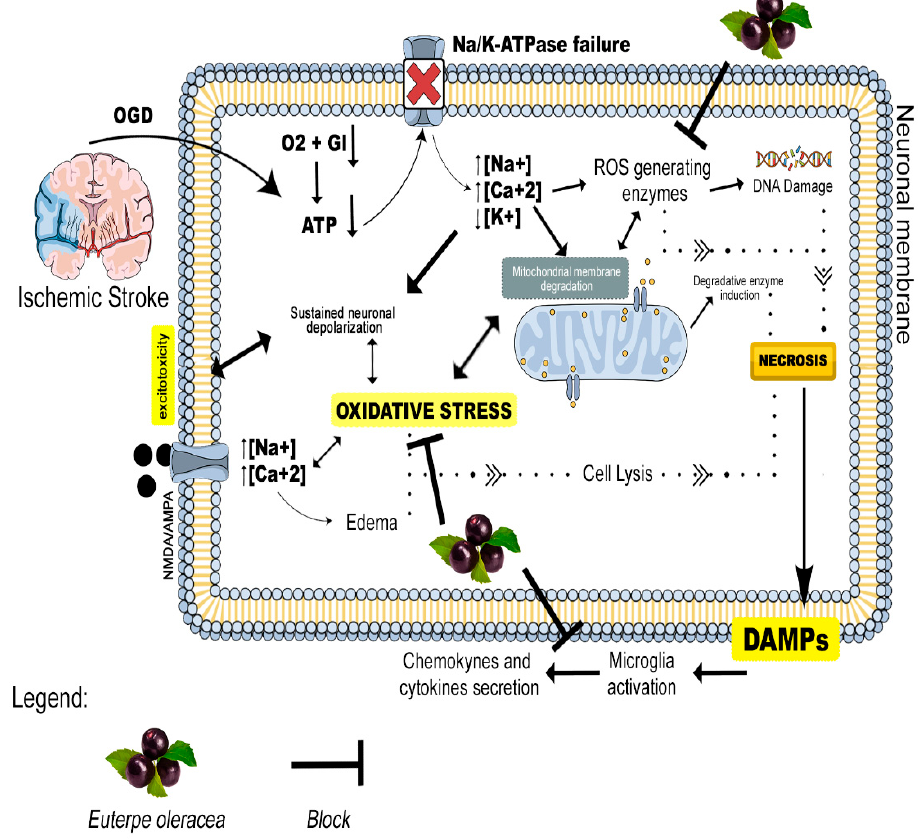
Figure 6. Pathophysiology of ischemic stroke and possible therapeutic targets of the Euterpe oleracea extract. OGD = Oxygen and Glucose Deprivation; Gl = Glucose; ATP = Adenosine Triphosphate; ROS = Reactive Oxygen Species; DAMPs = Damage Associated Molecular Patterns; NMDA = N- methyl-D-aspartate; AMPA = Alpha-amino-3-hydroxy-5-methyl-4-isoxazolepropionic